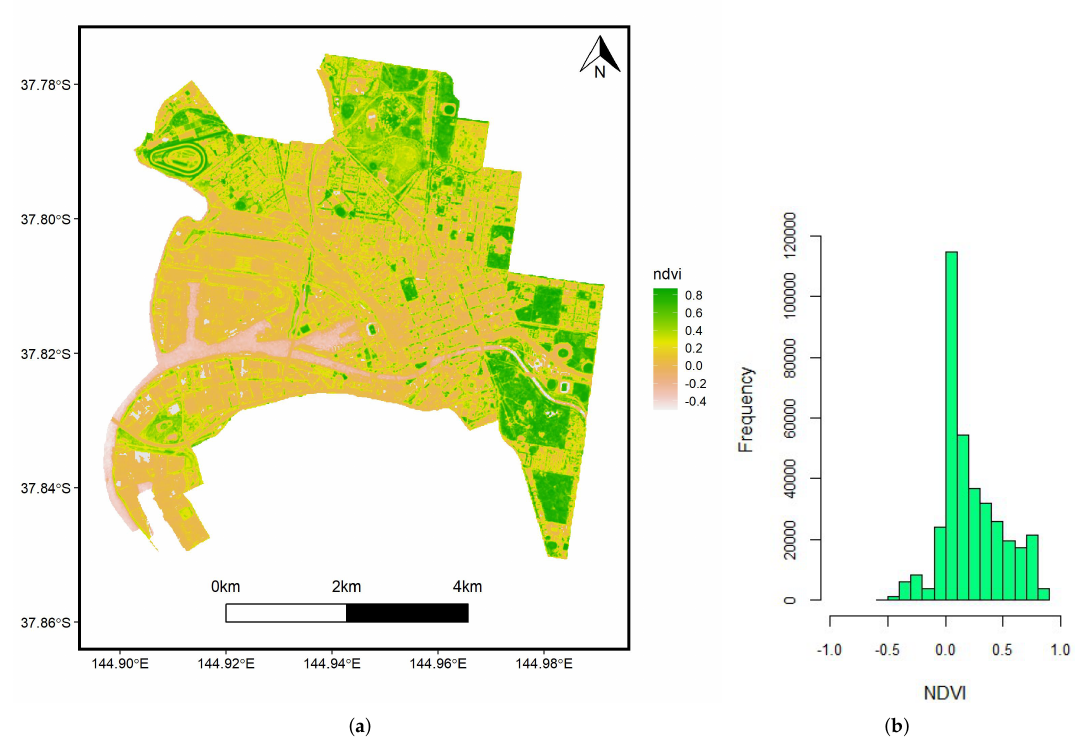
Figure 2. The NDVI map ( a ) and histogram of NDVI values showing their distribution ( b ) of City of Melbourne, Victoria,